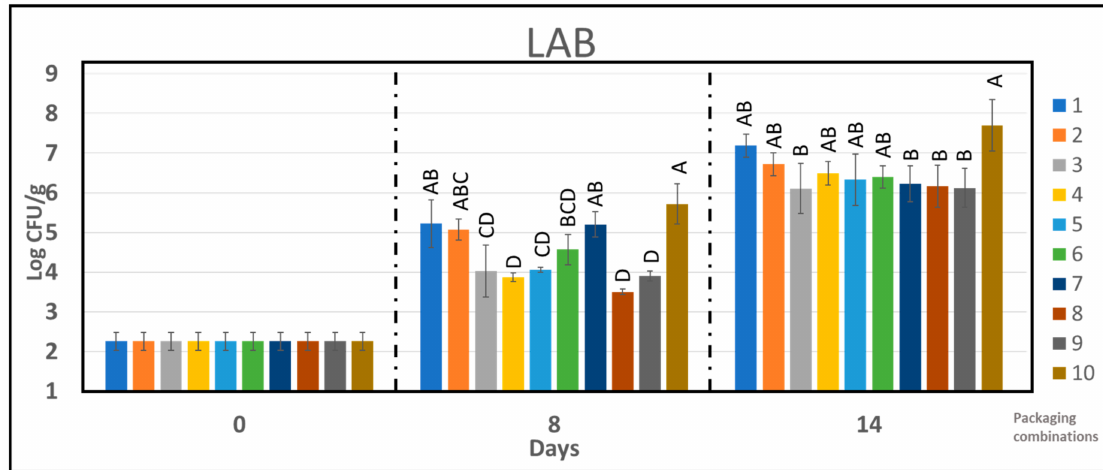
Figure 5. The effect of packaging combinations on the LAB counts in chicken samples during storage time of 14 days. One-way analysis of variance Tukey comparison is performed separately at sampling point 8 and 14 days. Tukey group is represented by upper case letters, samples which do not share the same letter are significantly